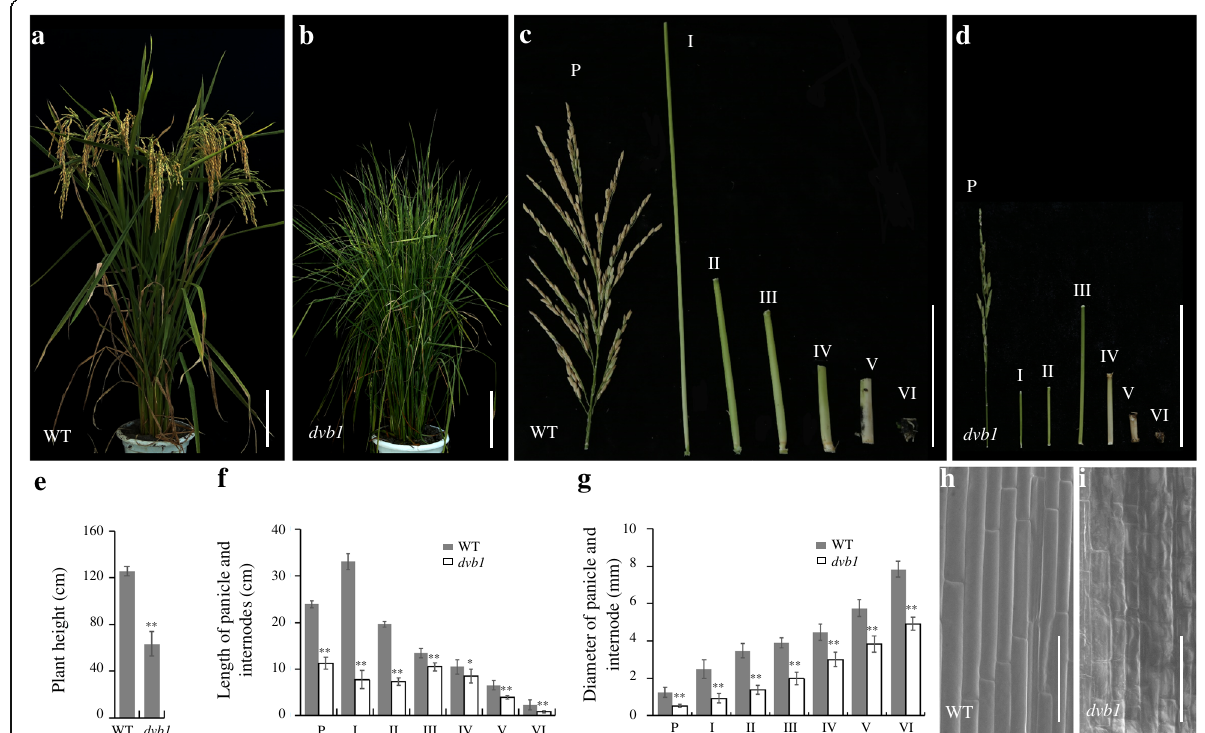
Fig. 1 Phenotypes of the dvb1 mutant and wild type. a , b Plants of the wild type ( a ) and the dvb1 mutant ( b ) at maturity. c , d Panicle and internodes of the wild type ( c ) and dvb1 ( d ). e – g Plant height ( e ), panicle and internode lengths ( f ), and diameter ( g ) in the wild type and the dvb1 mutant. h , i Scanning electron micrographs of the inner sheath surface in the wild type ( h ) and the dvb1 mutant ( i ). ‘ P ’ indicates the panicle and ‘ I-VI ’ indicate the internodes sequentially from the stem apex to the stem base. Values represent means ± SD from 10 biological samples. Asterisks indicate the significance of differences between the wild type and dvb1 as determined by Student ’ s t -test (*, 0.01 ≤ P <0.05; **, P <0.01). Scale bars: 15cm ( a , b ), 5cm ( c , d ), 100 μ m ( h , i